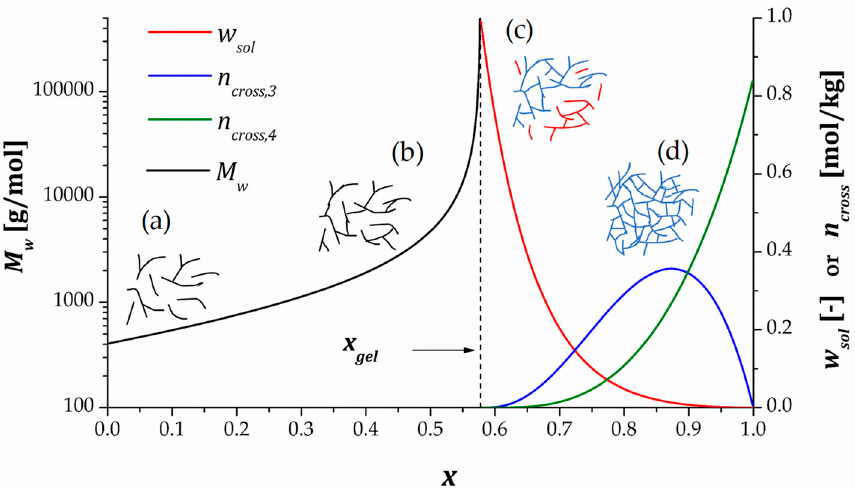
Figure 2. Evolution of network build-up statistical averages with degree of conversion x for an ideal A 2 − B 4 stepwise copolymerization.